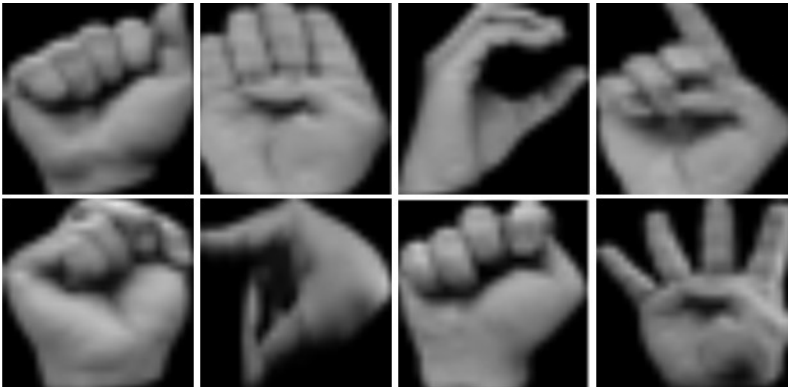
Figure 7. Sample images from ASL Digits